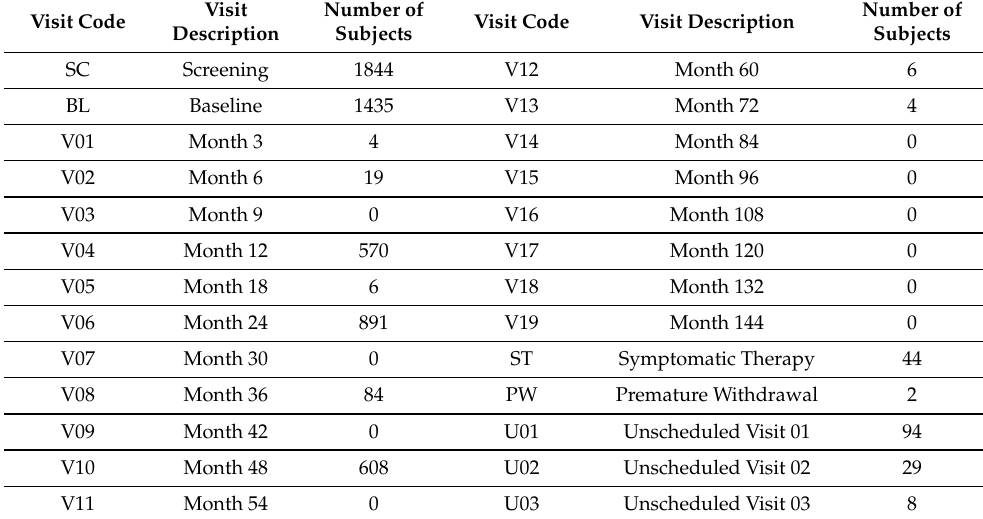
Table 2. Dataset description about the number of participants involved in each